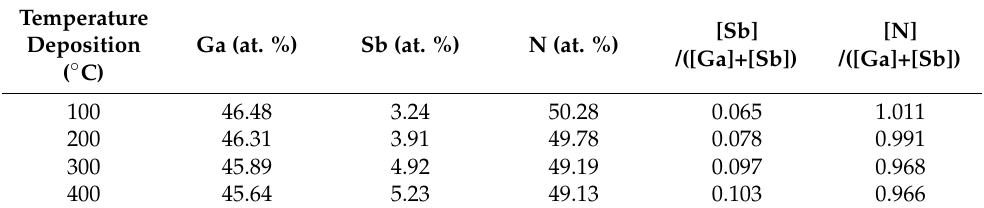
Table 1. The Composition of EDS Analyzing Data of the Deposited Sb 0.14 GaN Films at Heating Substrate Temperatures of 100, 200, 300, and 400 ◦ C.